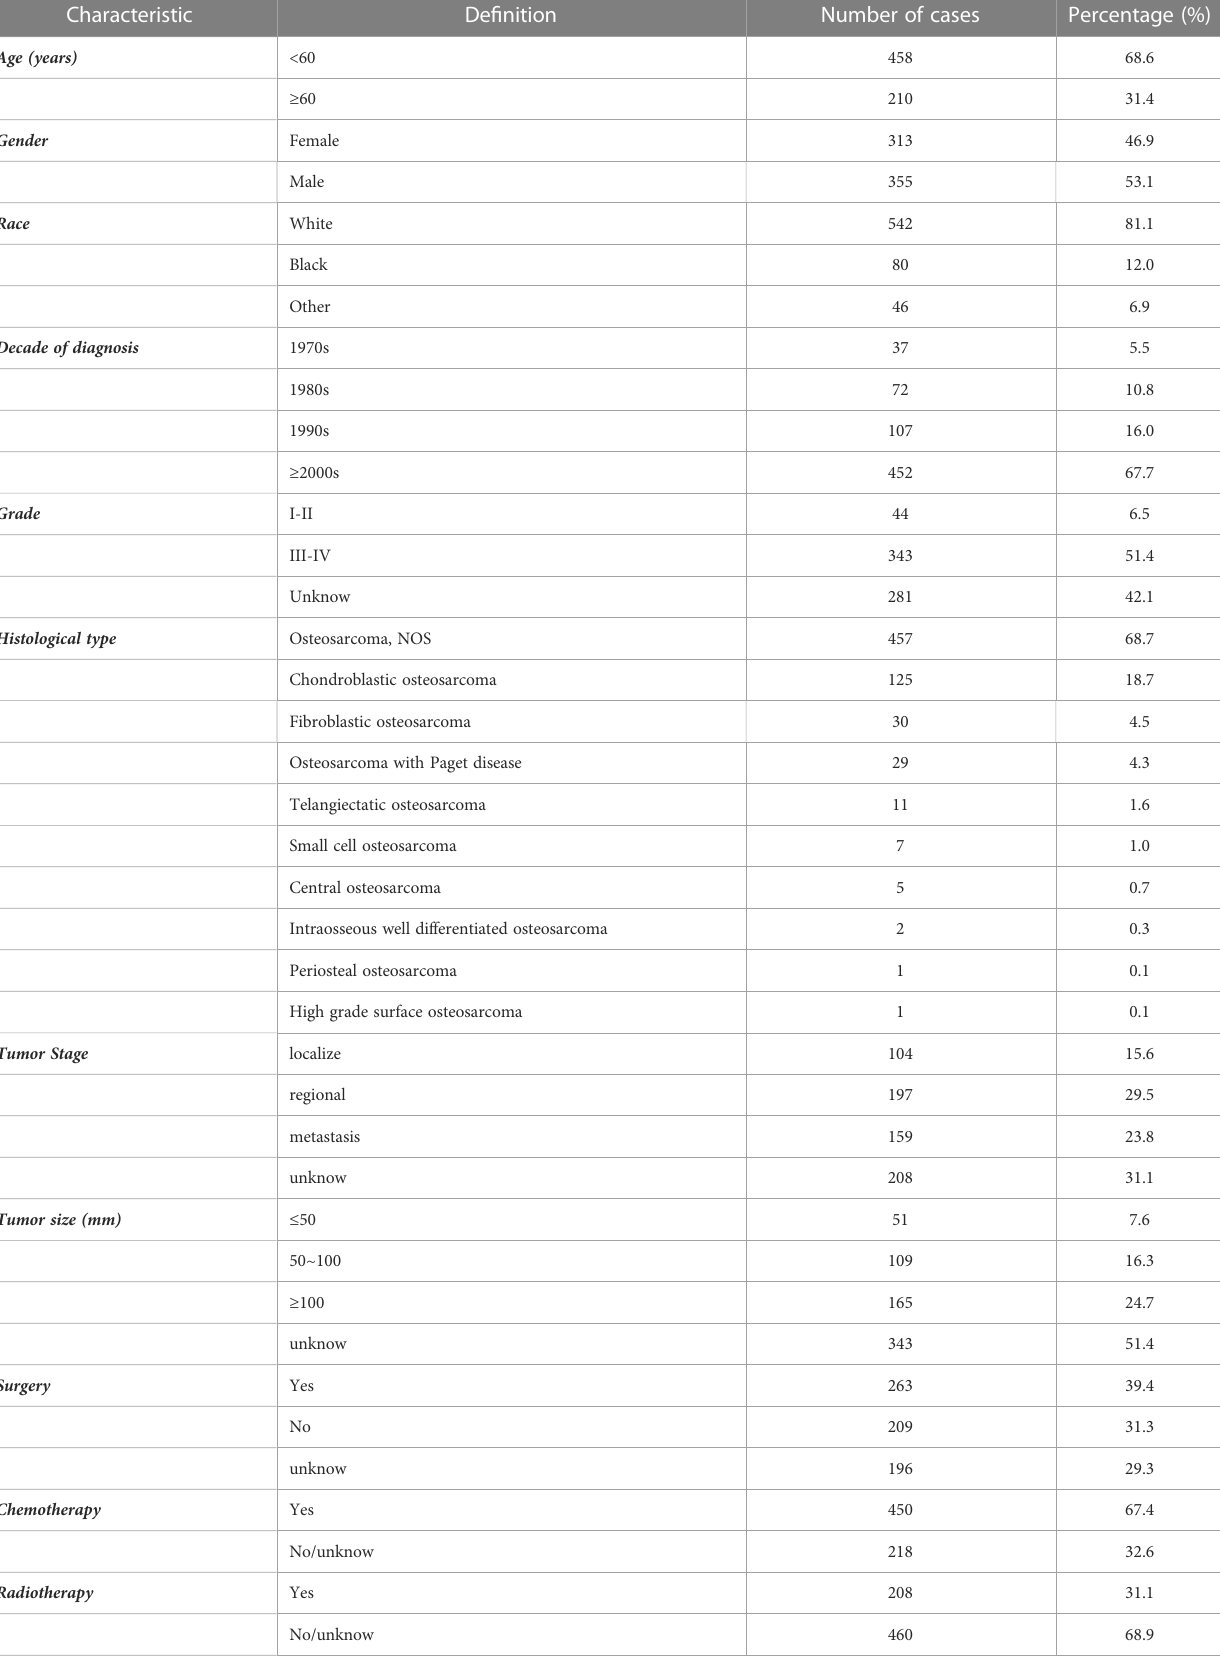
TABLE 1 Demographic and clinical characteristics of spinal osteosarcoma patients identi fi ed in the SEER database from 1975 to 2016.